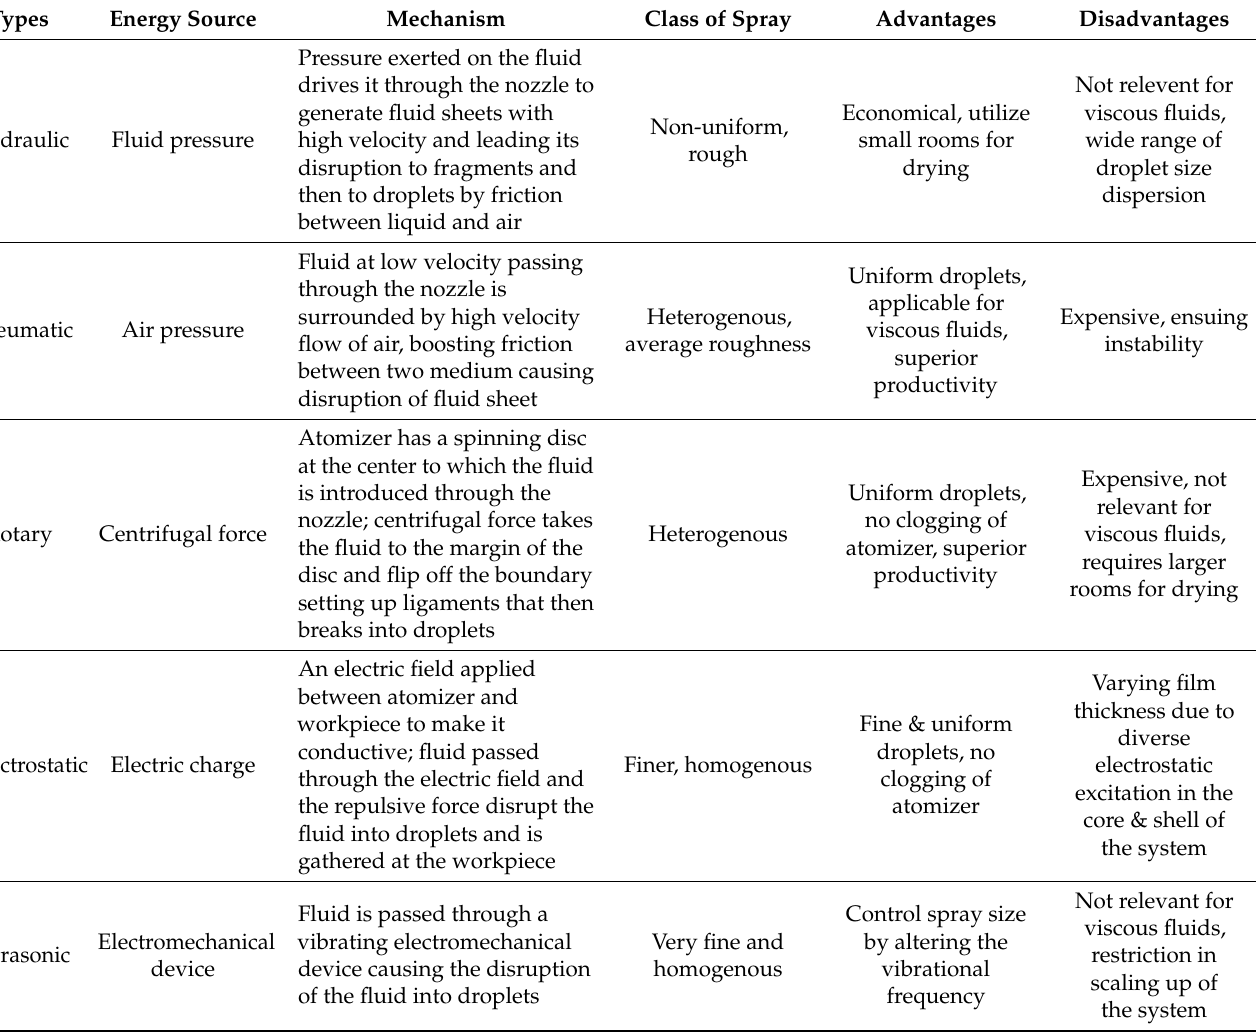
Table 2. Different atomization processes and its characteristics; Based on